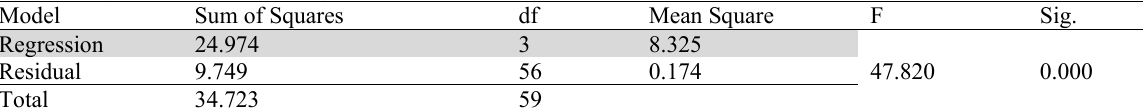
The summary of the results of Analysis of Variance (ANOVA